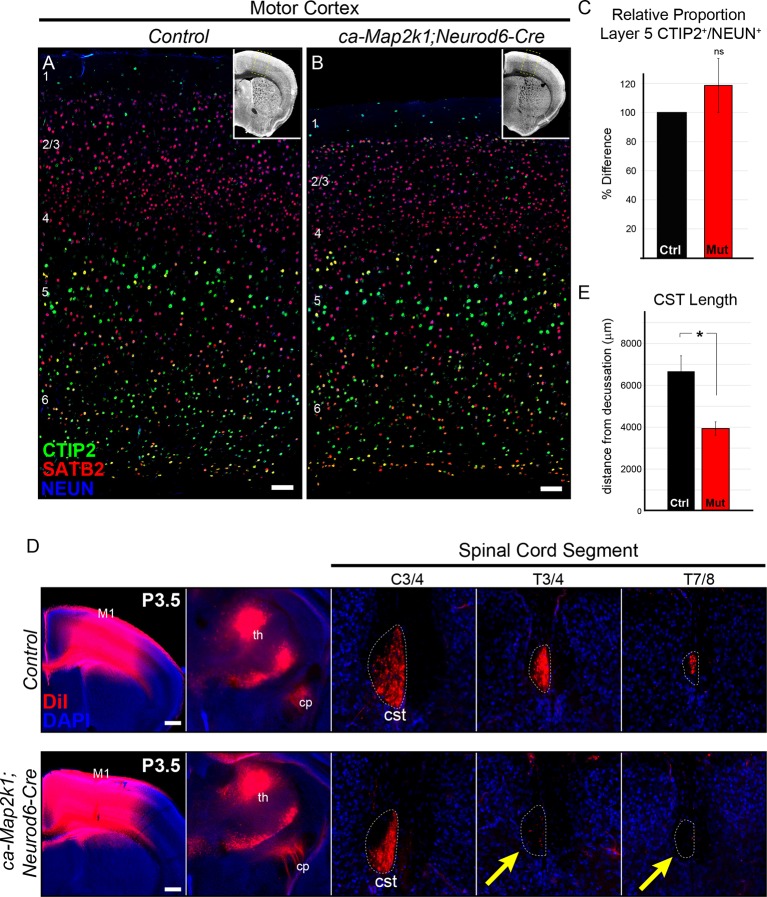
Gain of function ERK/MAPK signaling in ca-Map2k1;Neurod6-Cre mice decreases corticospinal extension into the spinal cord.(A–C) Representative confocal images of sensory cortices show that the expression and distribution of the callosal projection neuron marker, SATB2, and subcerebral projection neuron marker, CTIP2, in ca-Map2k1;Neurod6-Cre forebrains (B) appears normal when compared to littermate controls (A) (n=4, scale bar=100 µm). The relative proportion of CTIP2+ layer 5 neurons as a percentage of NEUN+ neurons within a radial unit did not show a significant difference between adult mutant and control motor cortices (C) (n=3, mean ± SEM, p=0.2). (D–E) In vivo DiI injections into P0 neonates were performed to label corticospinal axons during initial stages of elongation into the spinal cord (D). Analysis of DiI labeling in the spinal cord dorsal funiculus at P3 revealed a significant decrease in the extent of axonal elongation in mutant spinal cords relative to controls (E) (n=3, mean ± SEM, *p=0.033, scale bar=100 µm).